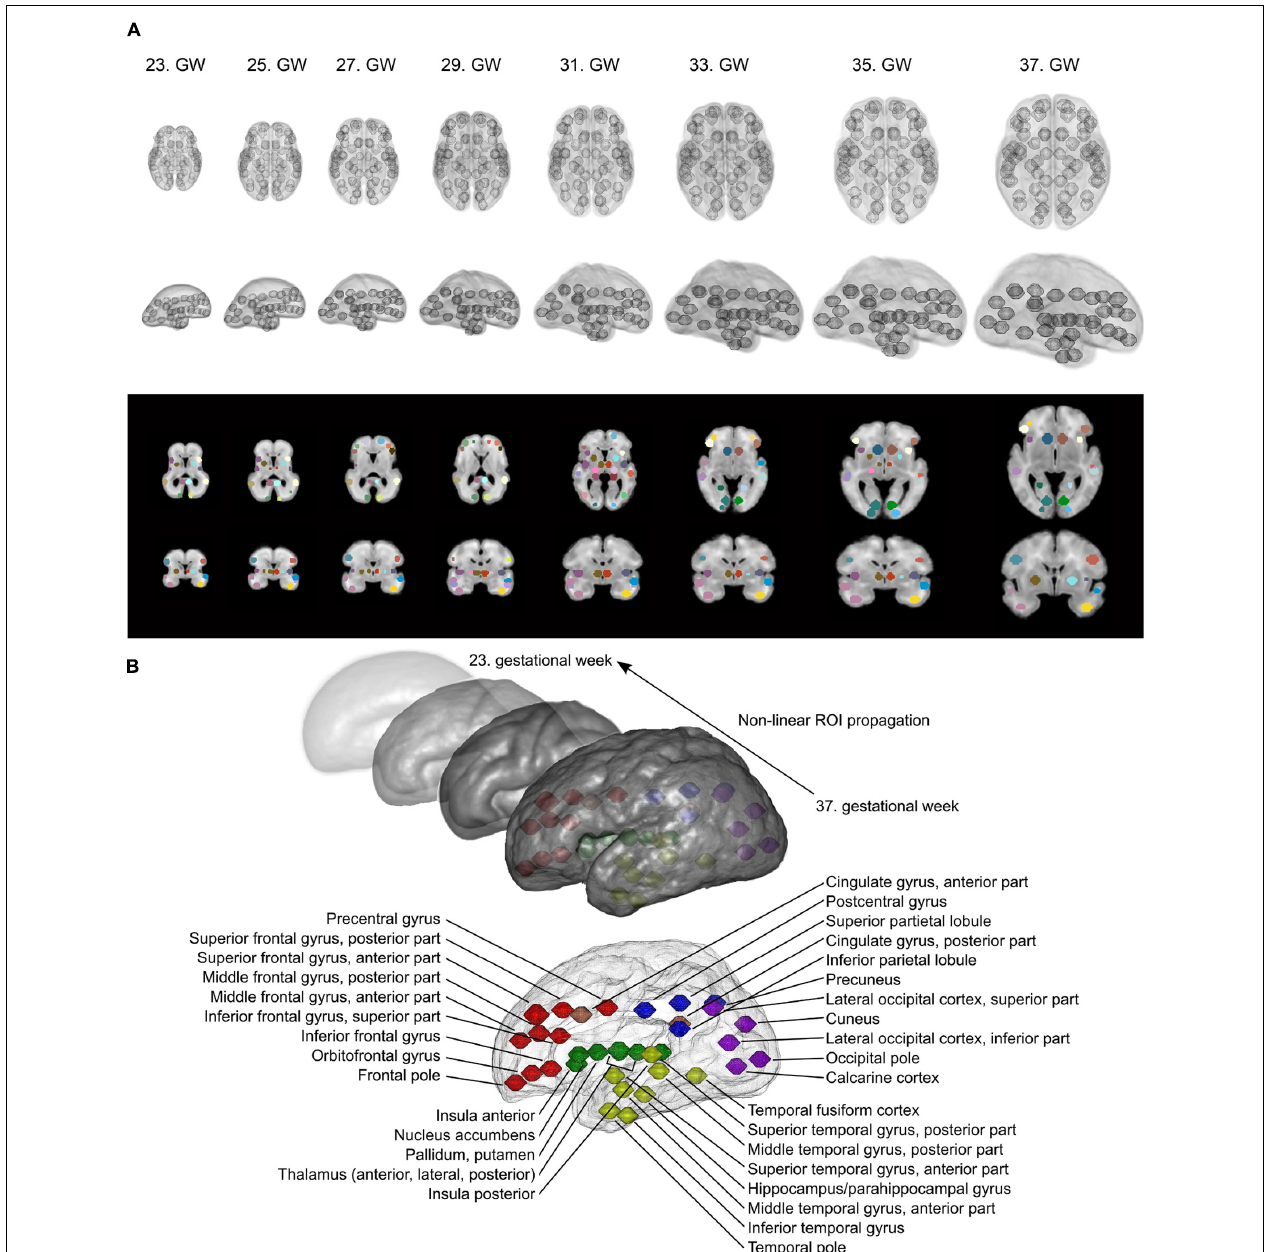
Three-dimensional renderings and cross-sectional anatomical images with ROIs are shown. (B) Anatomical nomenclature of the ROI system. Correspondence to major lobes or systems is marked with different colors: red = frontal lobe; blue = parietal lobe; purple = occipital lobe; yellow = temporal lobe; green = subcortical; pink = limbic/cingulate